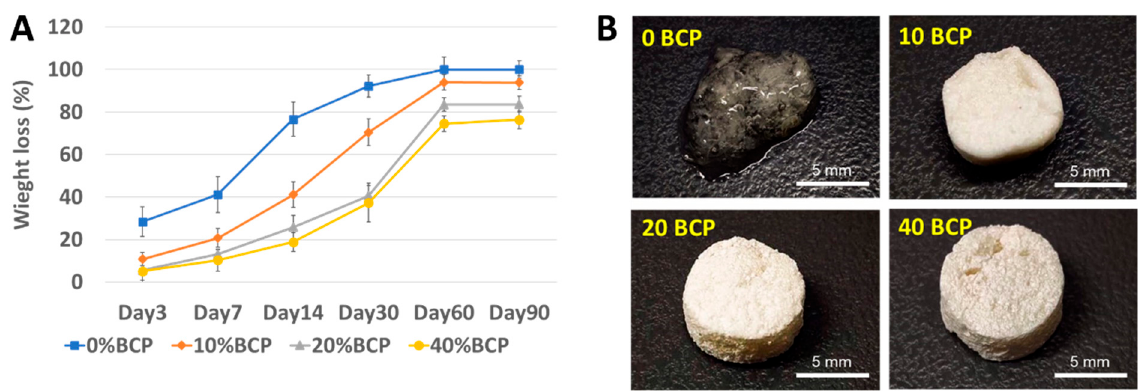
Figure 3. The enzymatic degradation behavior of CS/BCP/TSA scaffolds. ( A ) The weight changing of CS/BCP/TSA scaffolds at the time intervals of 1, 3, 7, 14, 30, and 60 days. ( B ) The gross structure of CS/BCP/TSA scaffolds before frizzed dry, at 30 days after enzymatic degradation.